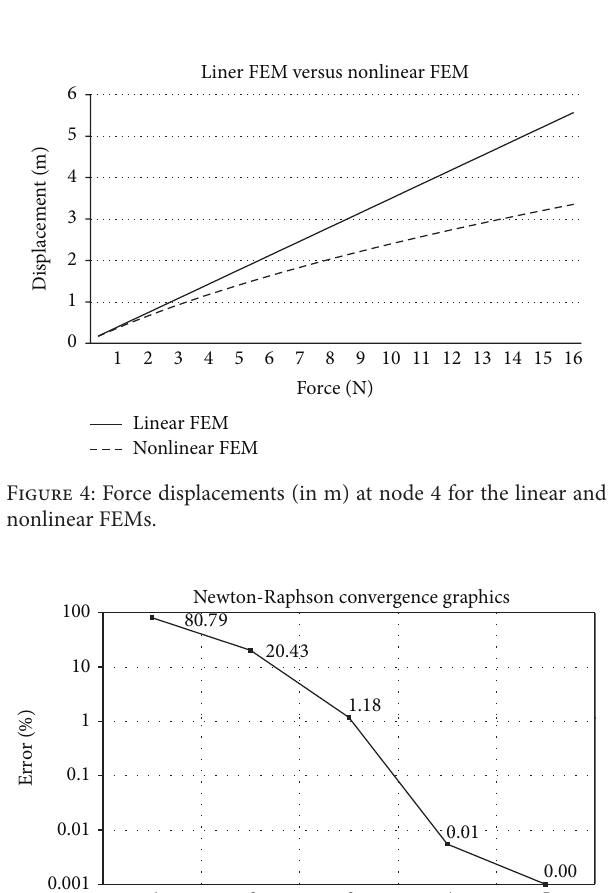
Figure 3: (a) The initial and final positions of the nodes for the linear FEM. (b) The initial and final positions of the nodes for the nonlinear FEM.